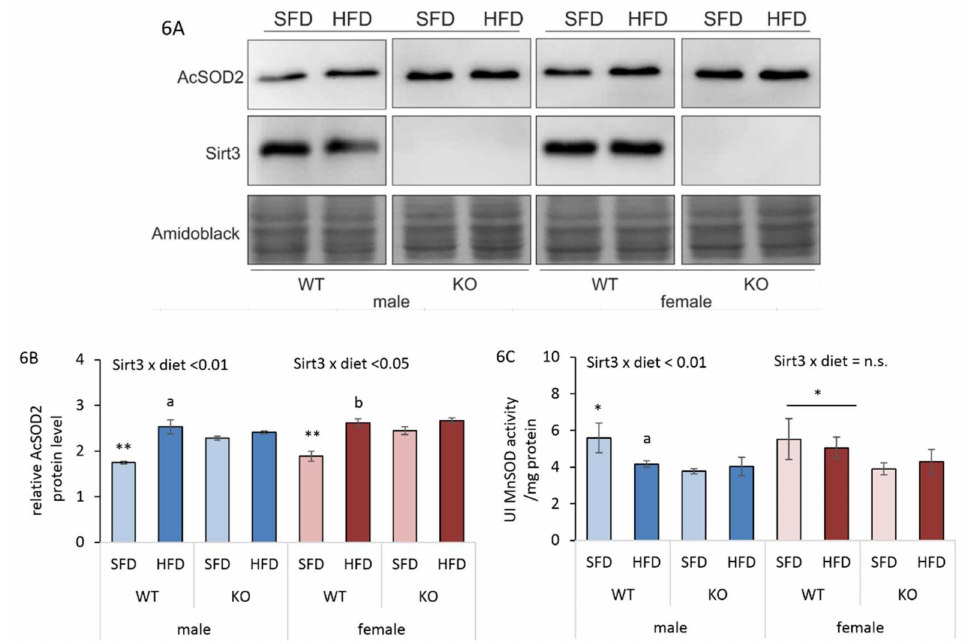
Figure 6. Sirt3 / MnSOD axis in liver of Sirt3 wild-type (WT) and knockout (KO) mice fed with a standard fat diet (SFD) or a high fat diet (HFD) for 10 weeks. ( A ) A representative immunoblot of hepatic Sirt3 and AcSOD2 protein expression. Amidoblack was used as a loading control. ( B ) A graphical display of averaged densitometry values for AcSOD2 protein expression. Males: HFD-fed vs. SFD-fed WT mice ( a p < 0.01); SFD-fed WT vs. KO mice (** p < 0.01). Females: HFD-fed vs. SFD-fed WT mice ( b p < 0.01); SFD-fed WT vs. KO mice (** p < 0.01). Males vs. females: no change. ( C ) MnSOD activity.